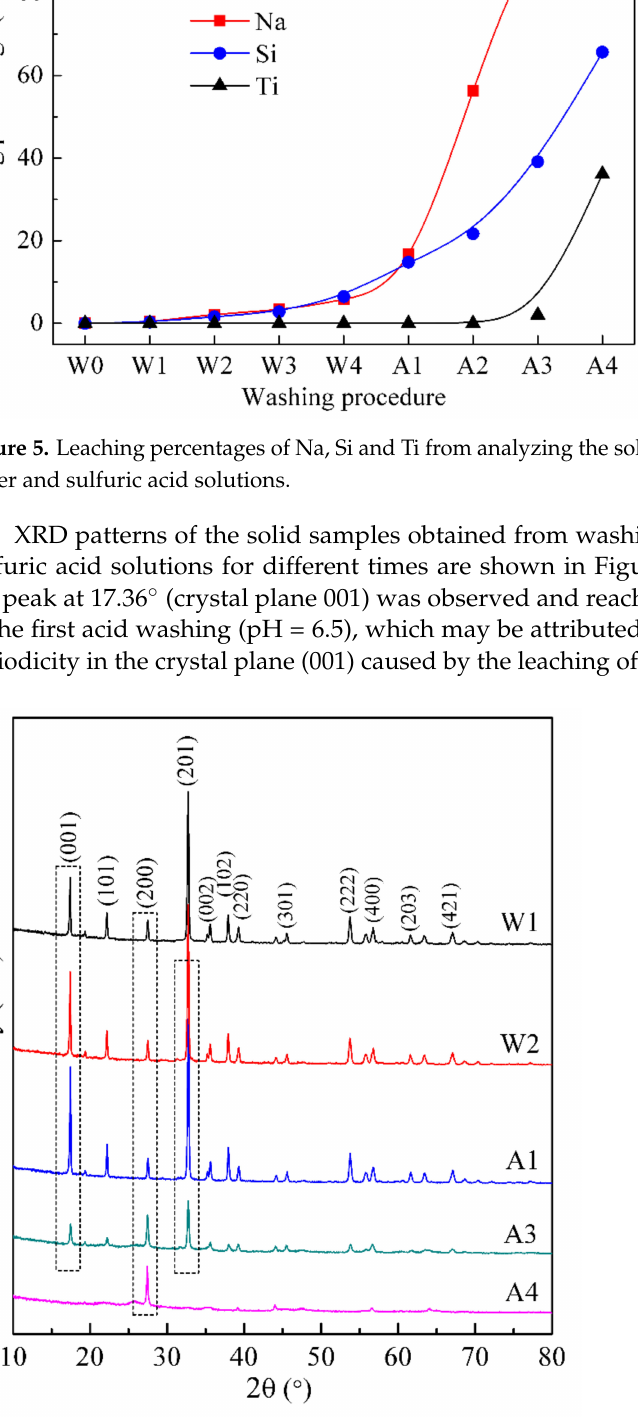
Figure 6. XRD patterns of the solid samples from washing natisite with water and sulfuric acid solutions. The peaks of crystal planes (001) and (201) of natisite gradually disappeared in the process of acid washing, which indicates that the layer structure may break down when a large proportion of sodium ions are leached out in sulfuric acid solutions. It is interesting that the XRD peak at 27.46 ◦ of crystal plane (200) is intensified gradually in the